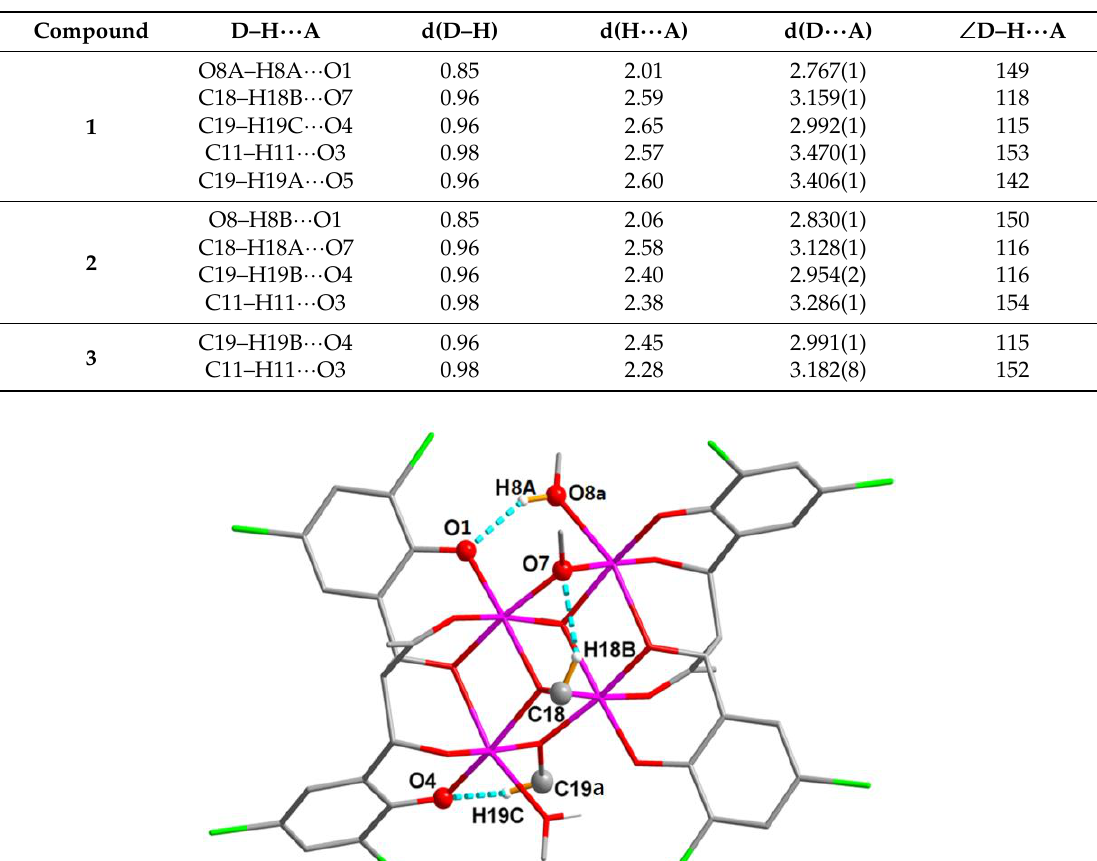
Figure 7. Part of 1D supramolecular structure containing C11c–H11c···O3 hydrogen bond interactions along b axis of the Mn III complex 1 (symmetry codes: c = 1 − x, 2 − y, 1 − z).